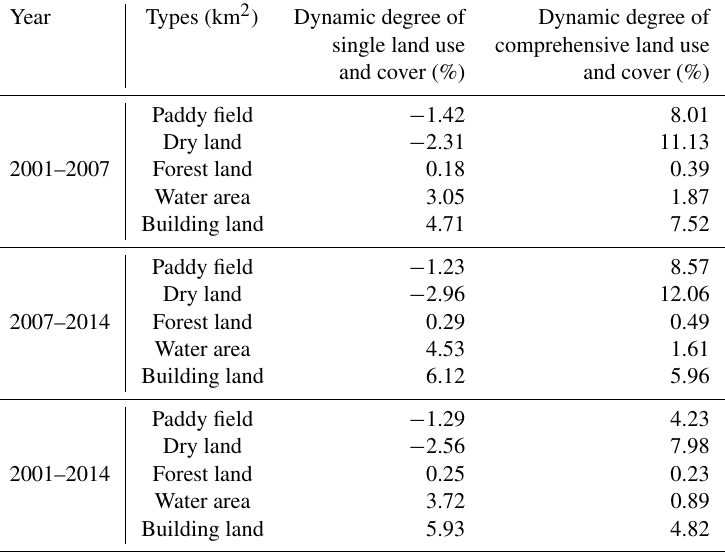
Table 1. Dynamic degree of land use and cover types in the Qiantang River basin.